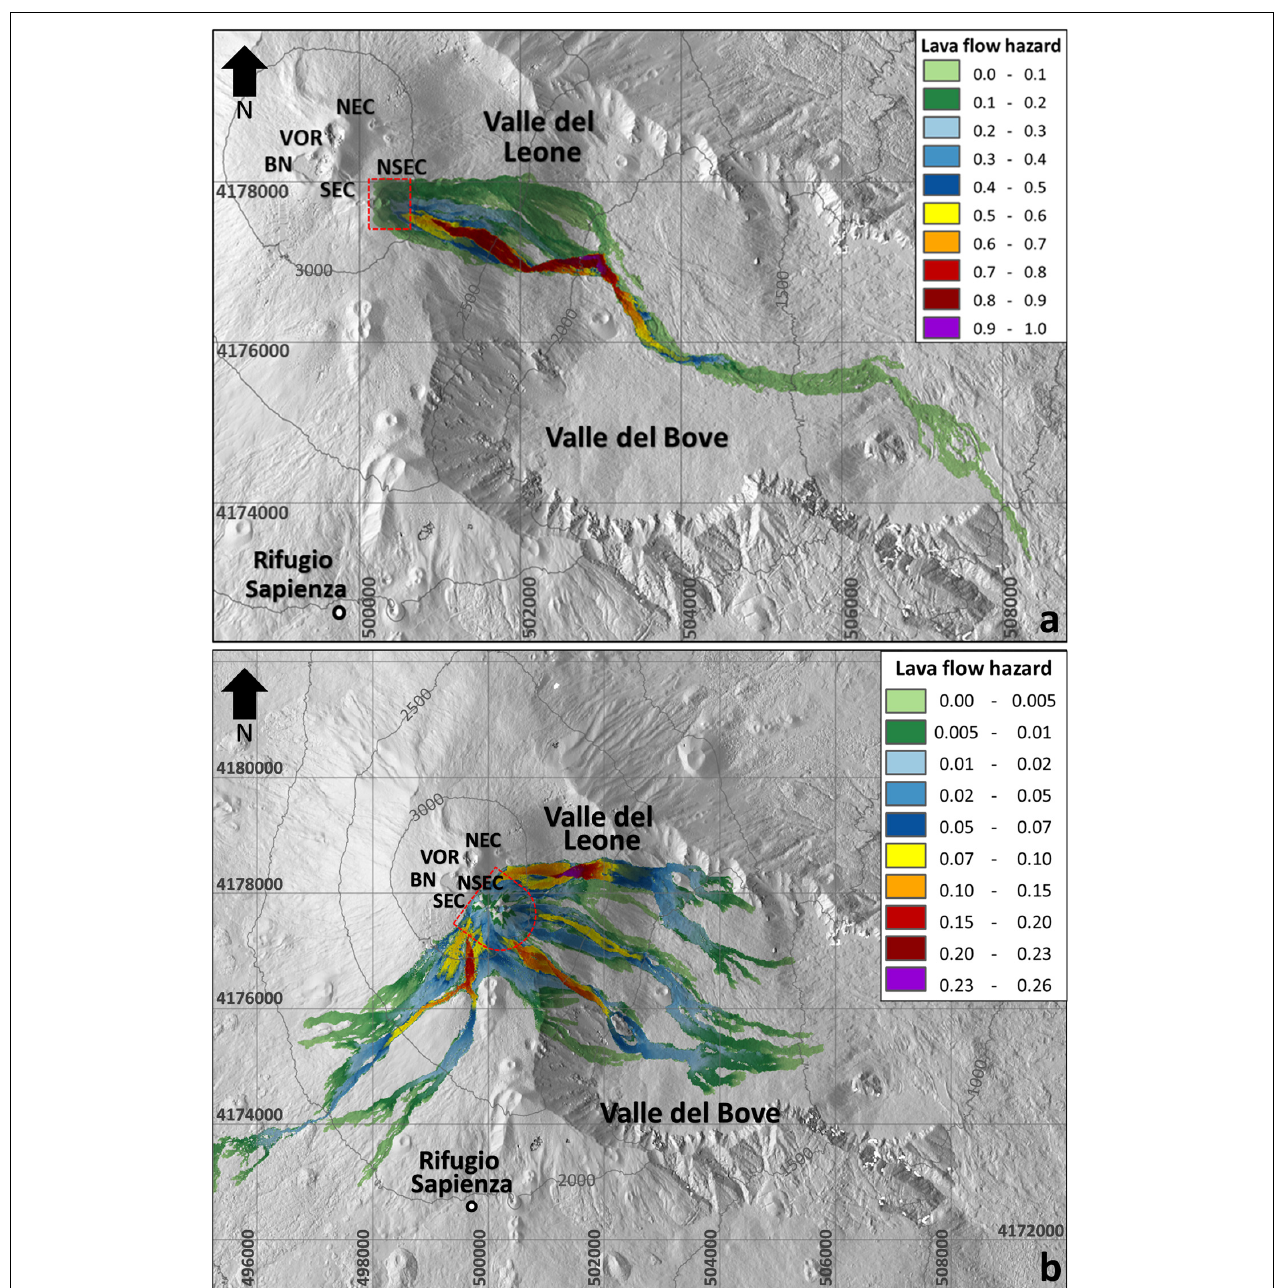
FIGURE 5 | (a) Lava flow hazard map at the SEC updated to 2011 (redrawn from Vicari et al., 2011b). Six MAGFLOW simulations were run on the 2007 DEM from 30 potential vents around the NSEC (red dashed area). (b) Inundation hazard mapping updated to 2018 and associated to lava flows emitted from 103 potential vents opening in the SEC zone (red dashed area). MAGFLOW simulations were performed on the most recent available DEM, which was derived from the Pléiades images acquired on 18 July 2016.